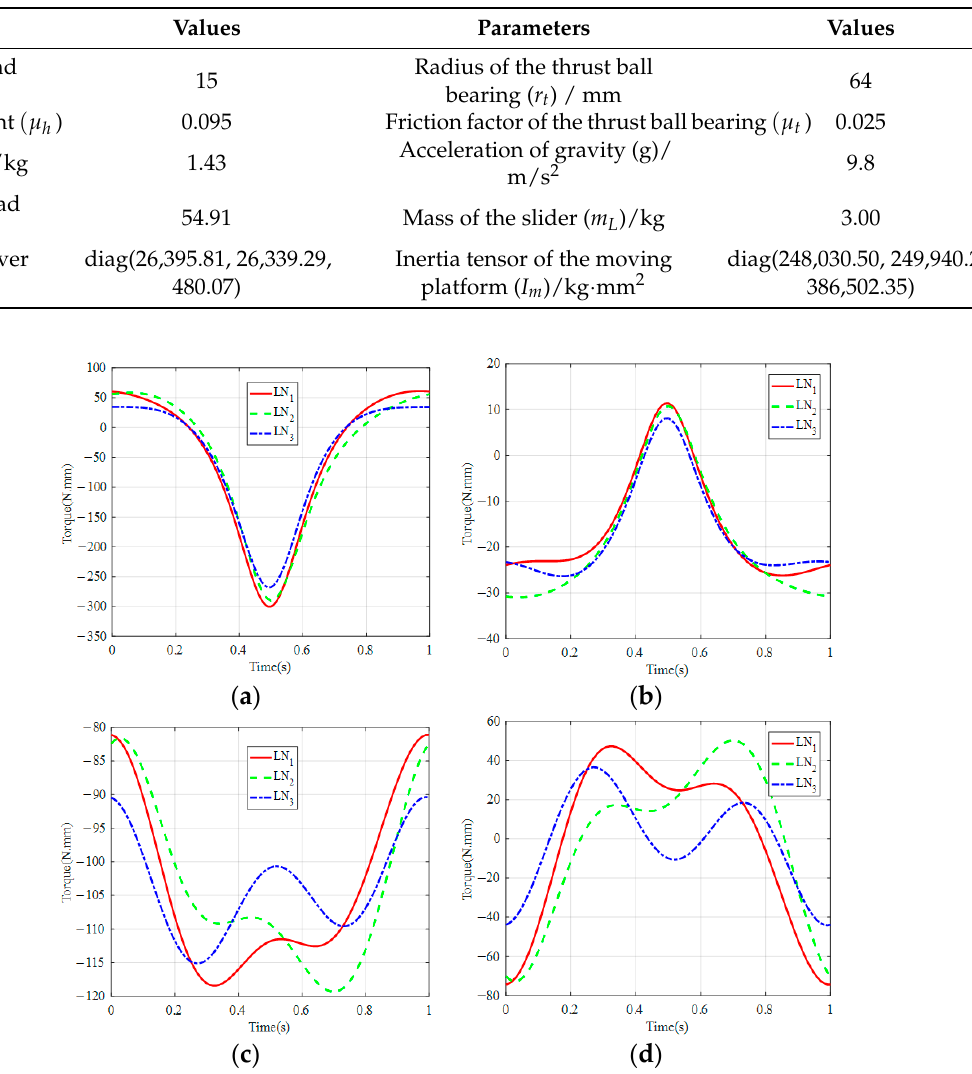
Table 2. Mass and inertia parameters of the parallel manipulator.